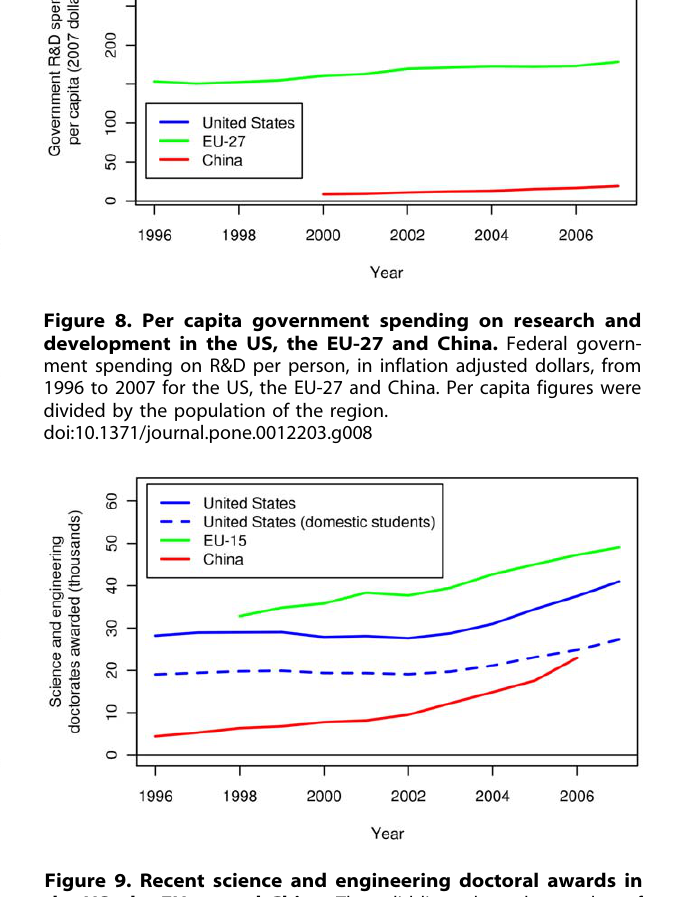
Figure 9. Recent science and engineering doctoral awards in the US, the EU-15 and China. The solid lines show the number of doctoral degrees granted by institutions in each region. In addition, the dashed line shows the number of doctoral degrees granted by the US